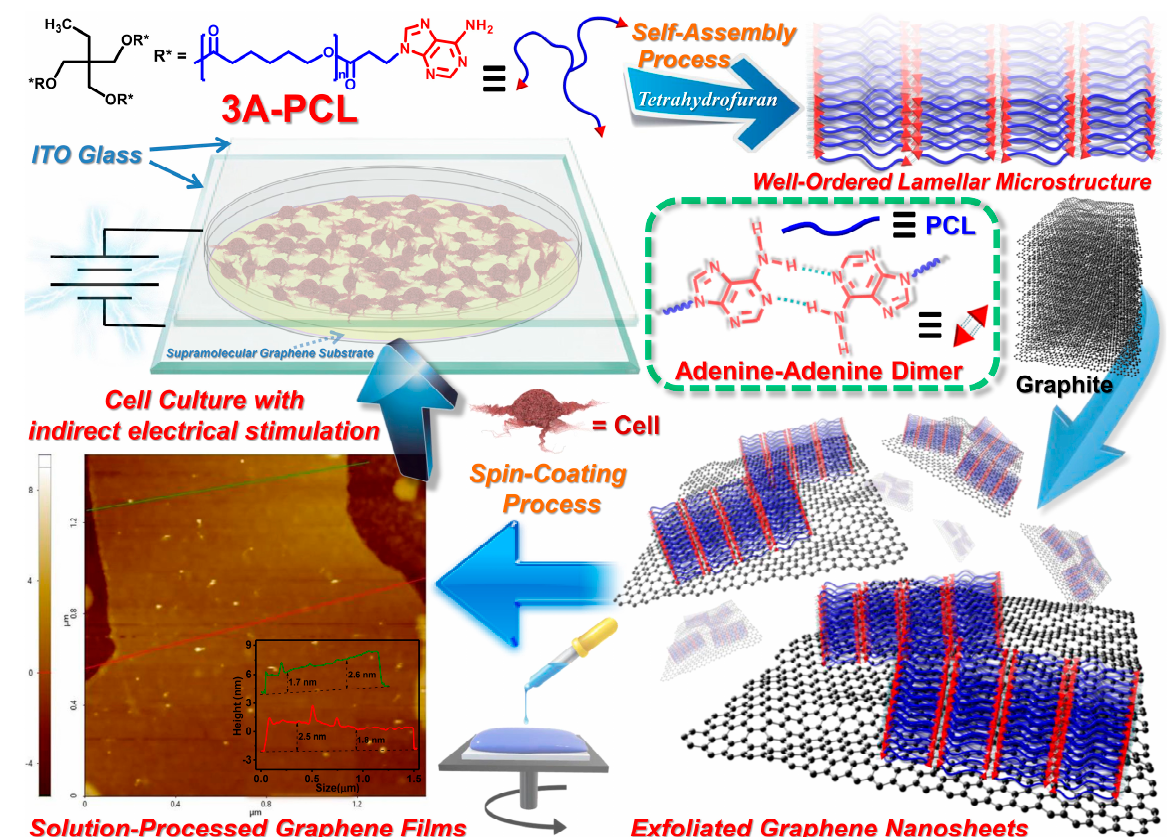
Scheme 1. Graphical illustration for the development of supramolecular